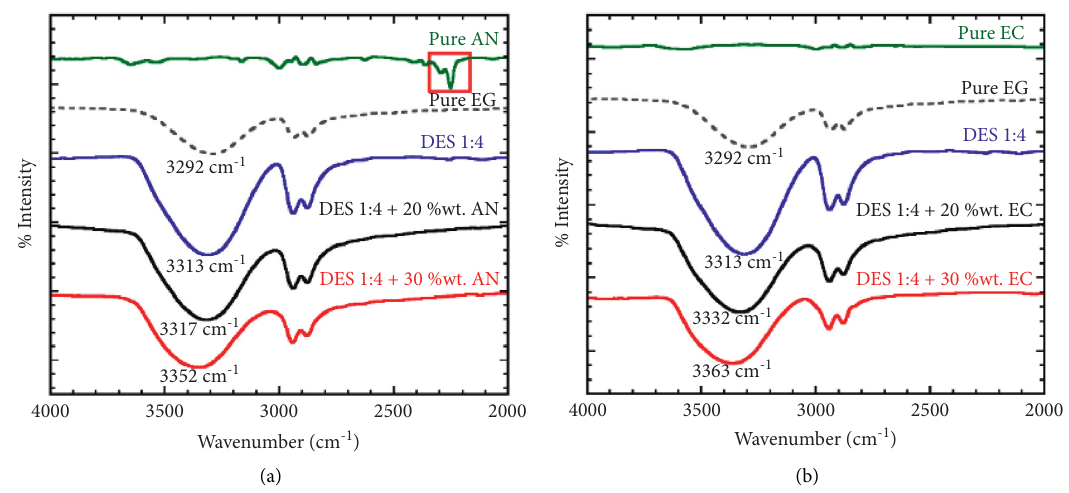
Figure 1: IR spectra of DES-organic solvent mixtures with different amounts of acetonitrile (a) or ethylene carbonate Table 1: The onset temperatures ( T d ) corresponding to the stages of weight loss of DES-based electrolytes. Mixture